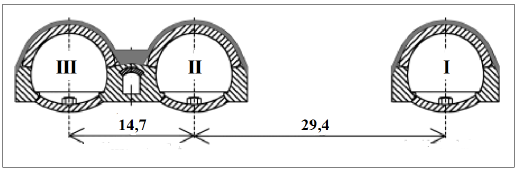
Figure 1. Vinohrady tunnels ([1] –